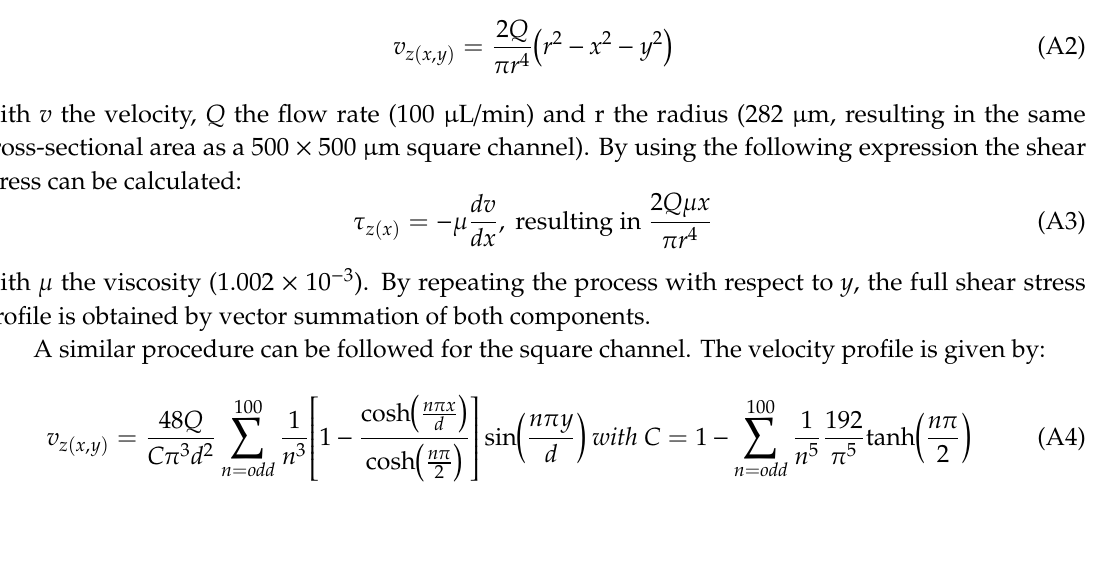
a blocked channel on the right hand side; ( e ) Flow field at the right hand merging point; ( f ) Flow field